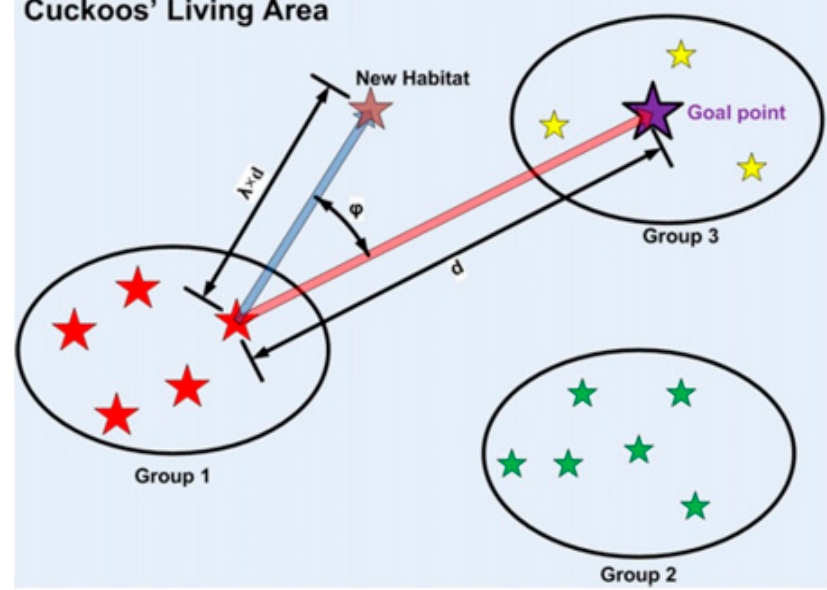
Figure 6. Cuckoo immigration toward the goal point process.